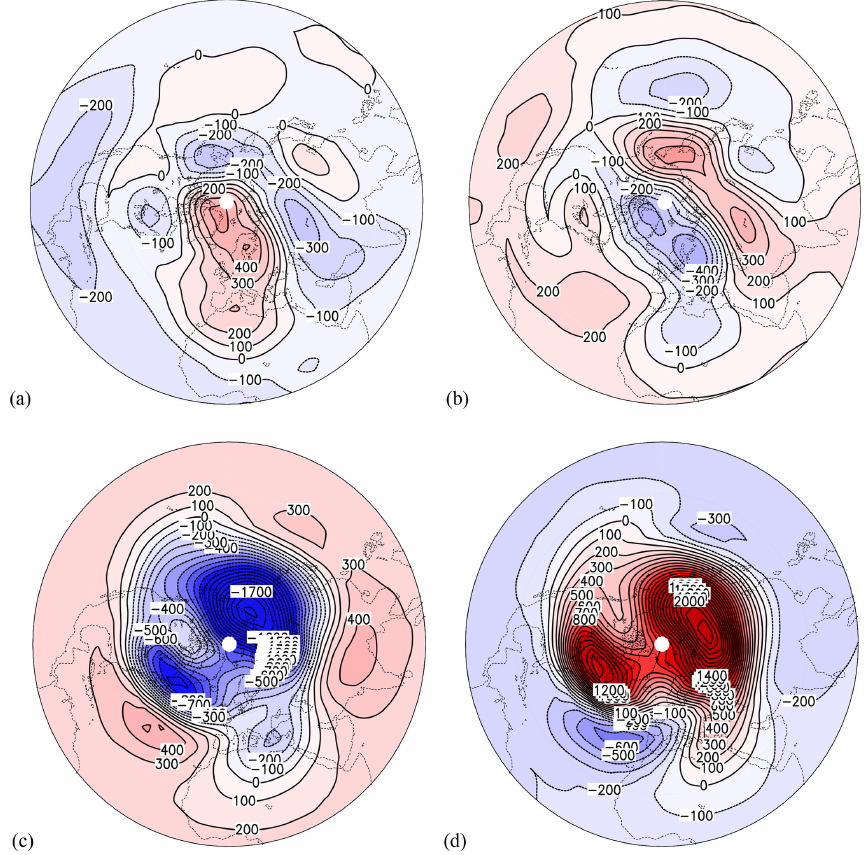
Figure 12. Regression (in mkm − 1 ) between the SPH (24–31-day filtered) time series and the CMAM geopotential height time series at 0.01hPa (a, b) and at 1hPa (c, d) for time lags of − 12 days (a, c) and 0 days (b, d) for the period October 1985 to April 1986. The contour interval is 100mkm − 1 , and reddish (bluish) areas show positive (negative) regression